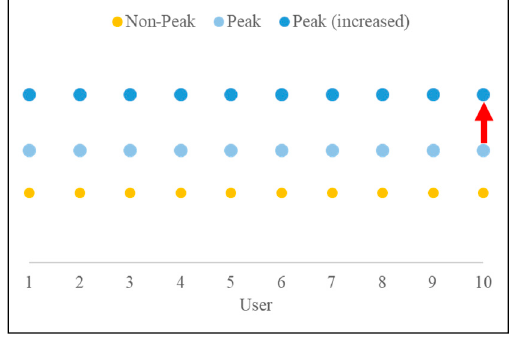
Figure 3. Peak time preference distribution setting.